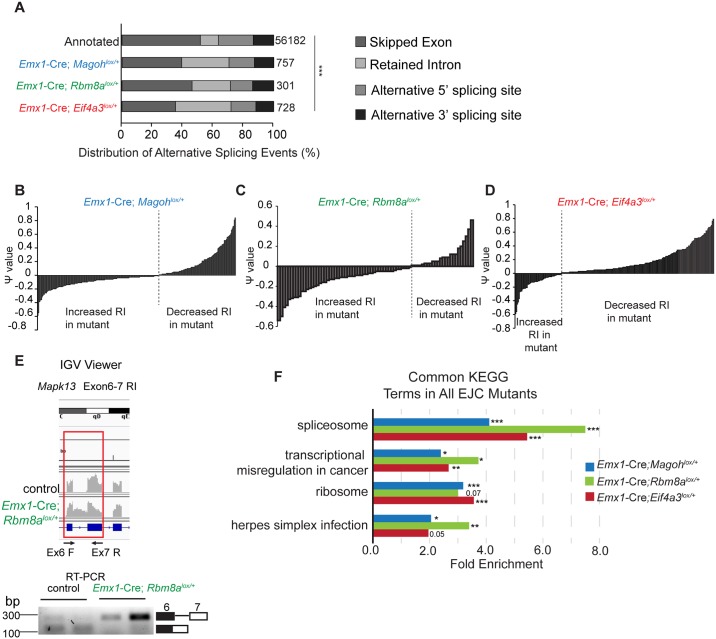
Haploinsufficiency for EJC components alters mRNA splicing of splicing regulators.(A) Bar graph showing alternative splicing events for each mutant relative to the control. (B-D) Clustered column graphs of the distribution of ψ values of all identified intron retention (RI) events in E10.5 dorsal cortices for each EJC mutant, using a threshold of 20 for Bayes factor. Ψ<0 indicates higher probability for the mutant to have intron retention when compared to the control. (E) Top: IGV view of increased Mapk13 intron 6–7 reads in red frame. Primers indicated as arrows. Bottom: RT-PCR showing increased Mapk13 RI isoforms in Emx1-Cre;Rbm8alox/+ E11.5 dorsal cortices compared to the control. (F) Bar graph of common KEGG terms that were significant in all 3 EJC mutants, showing corresponding enrichment score. ANOVA (A), Modified fisher’s exact test (F), *, p<0.05, **, p<0.01, ***, p<0.001.